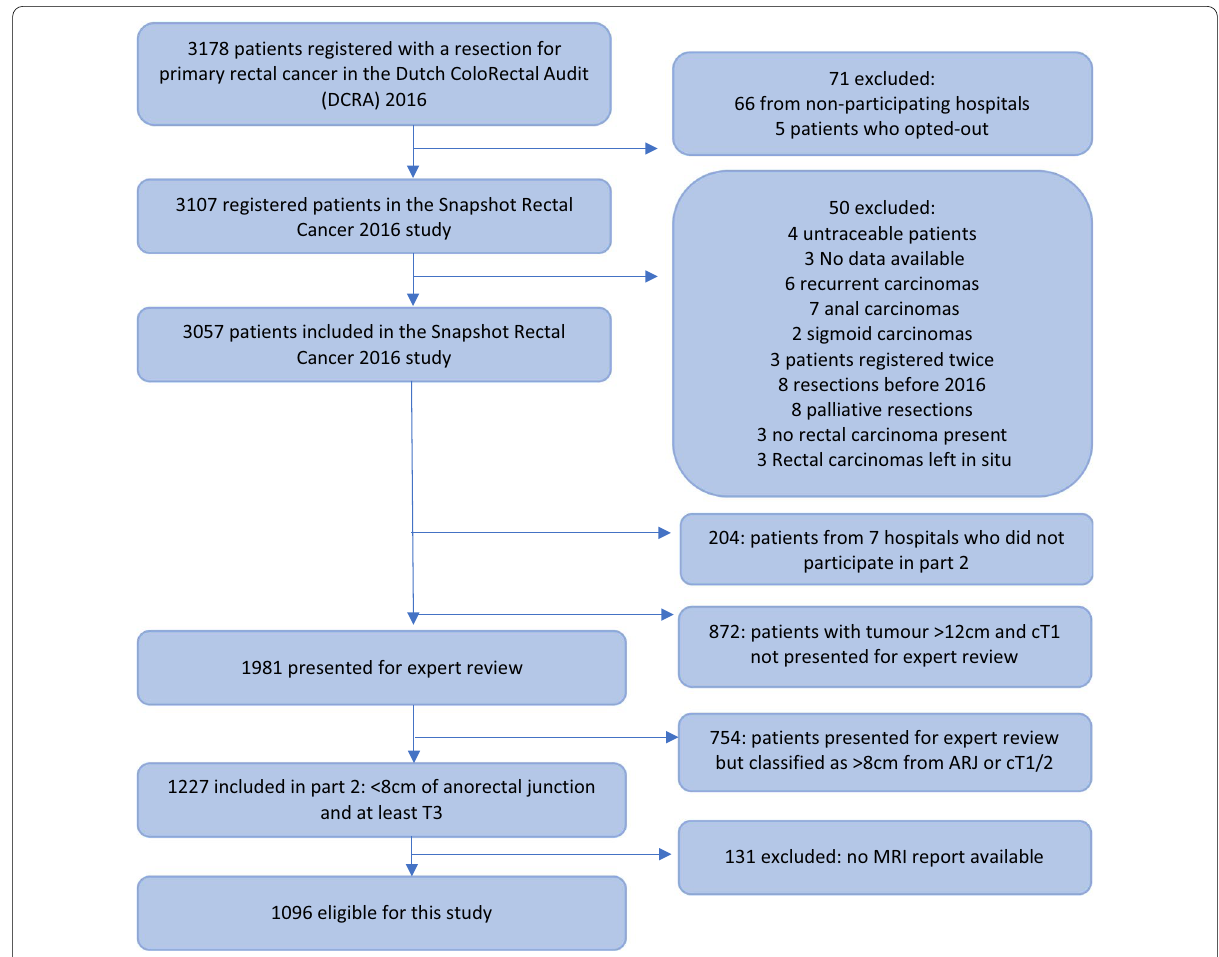
Fig. 1 Flowchart of patient